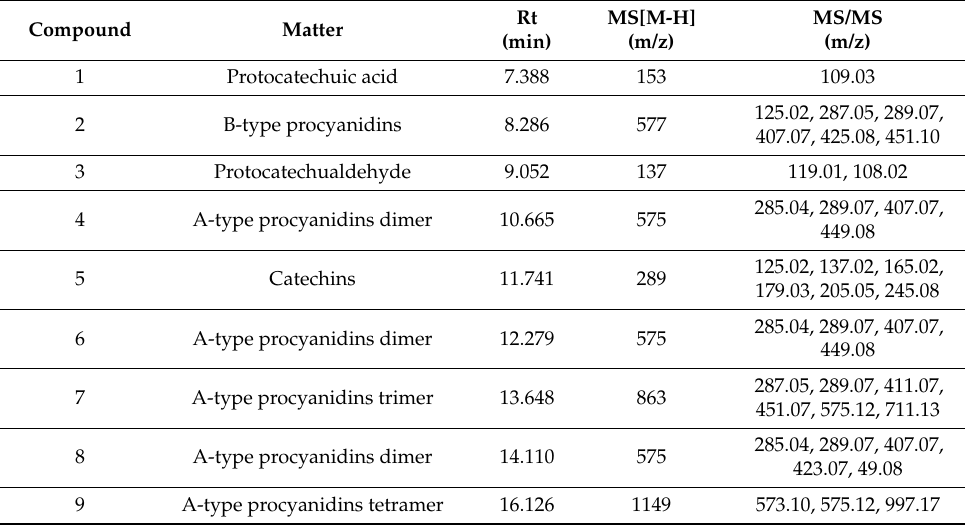
Table 2. Mass spectrometry information of the main compounds in